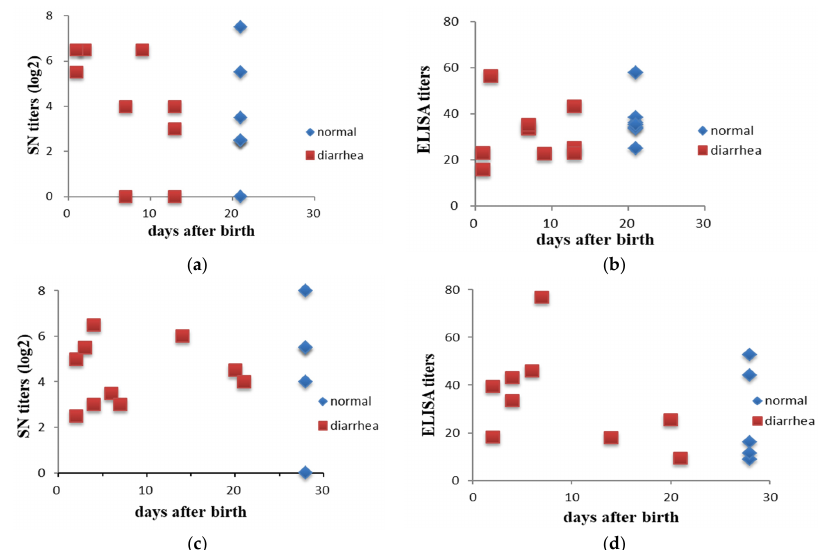
Figure 1. Comparison of the distribution of serum neutralization and ELISA antibody titers in piglets with or without diarrhea in farms SL ( a , b ) and RS ( c , d ). Each point represents one litter and sera were collected from 2 piglets 2 days after birth from each sow. For the SL farm, n = 9 and 7 for litters with or without diarrhea, respectively, and for the RS farm, n = 10 and 5 for litters with or without diarrhea, respectively.